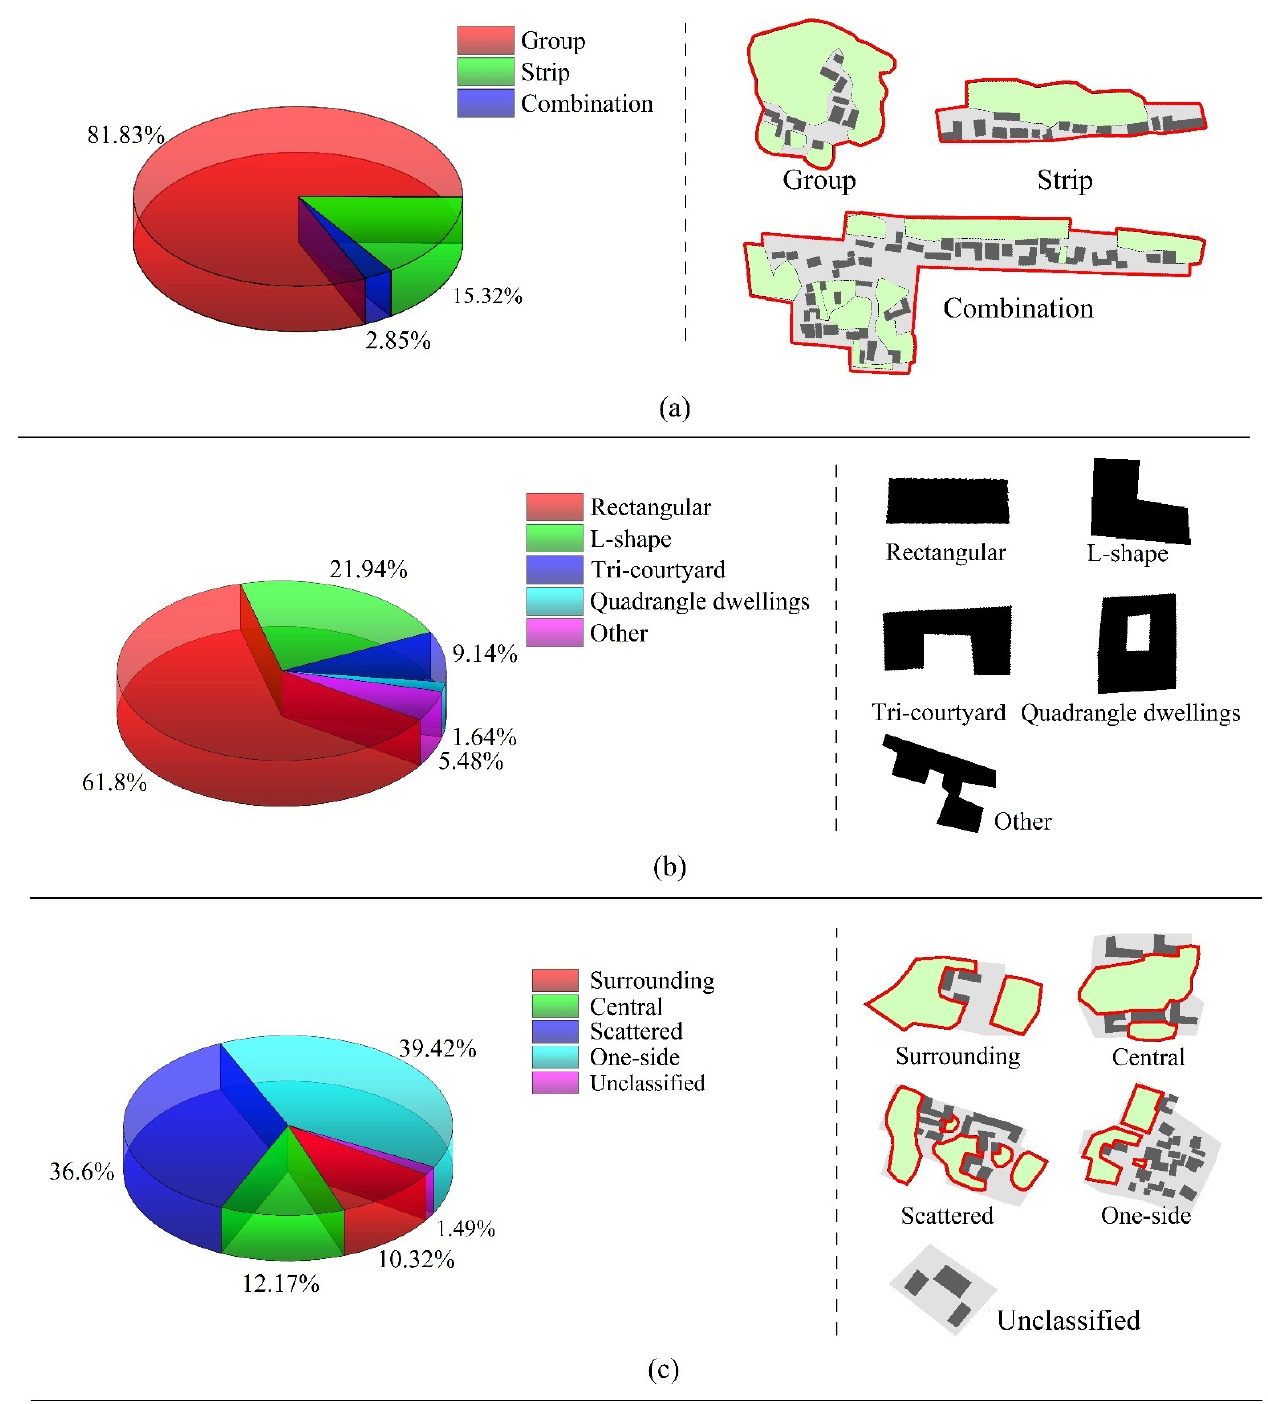
Figure 7. Classification results in main body shape, architectural form, and vegetation distribution: ( a ) pie chart of Linpan shapes and schematic diagram, ( b ) pie chart of building form and schematic diagram; and ( c ) pie chart of vegetation distribution and schematic diagram.